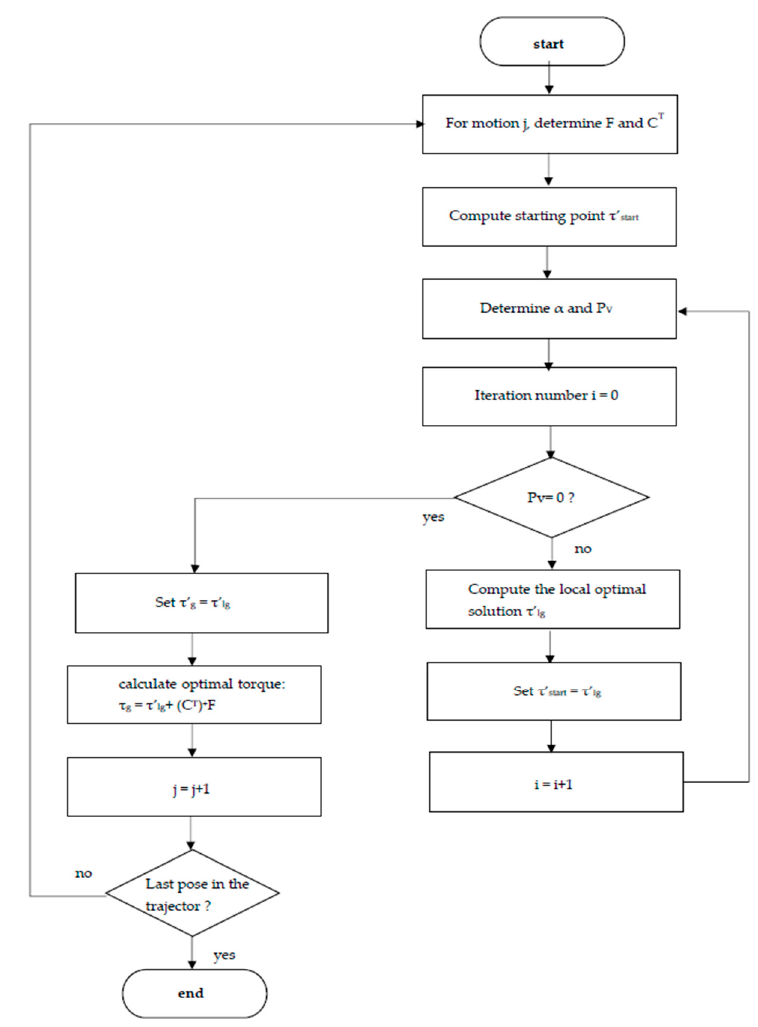
Figure 7. Flowchart of the optimization algorithm.